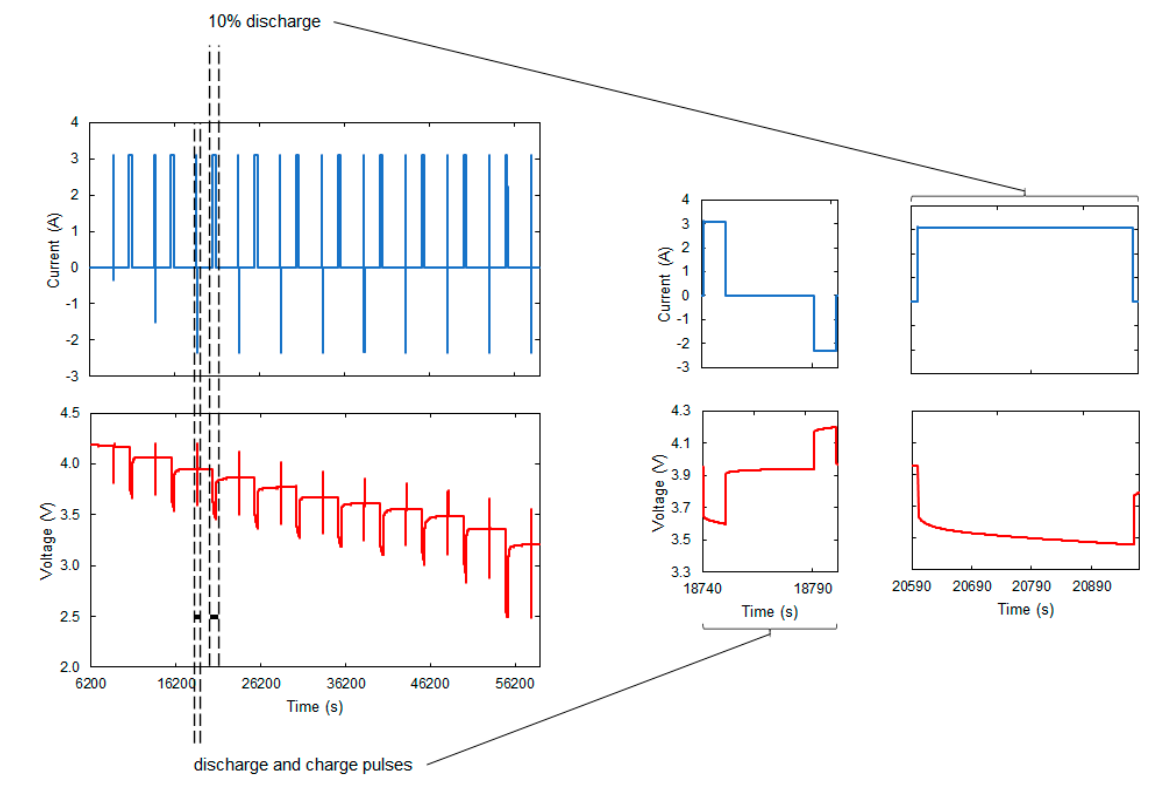
Figure 4. HPPC test profile for the NCA cell.